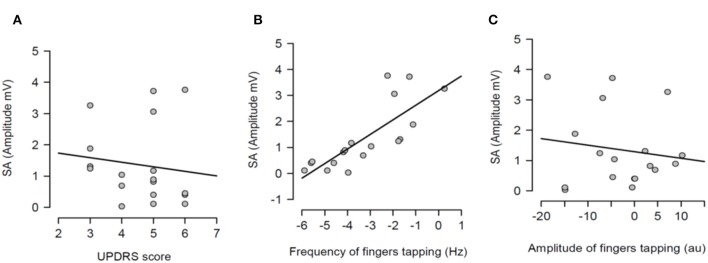
Regression analysis between dopaminergic changes of sensory attenuation (SA) and dopaminergic changes of each measure of bradykinesia [UPDRS score (A), frequency of fingers tapping (B) and amplitude of fingers tapping (C)]. The dopaminergic changes of each variable were calculated through the difference between OFF and ON values for each variable.